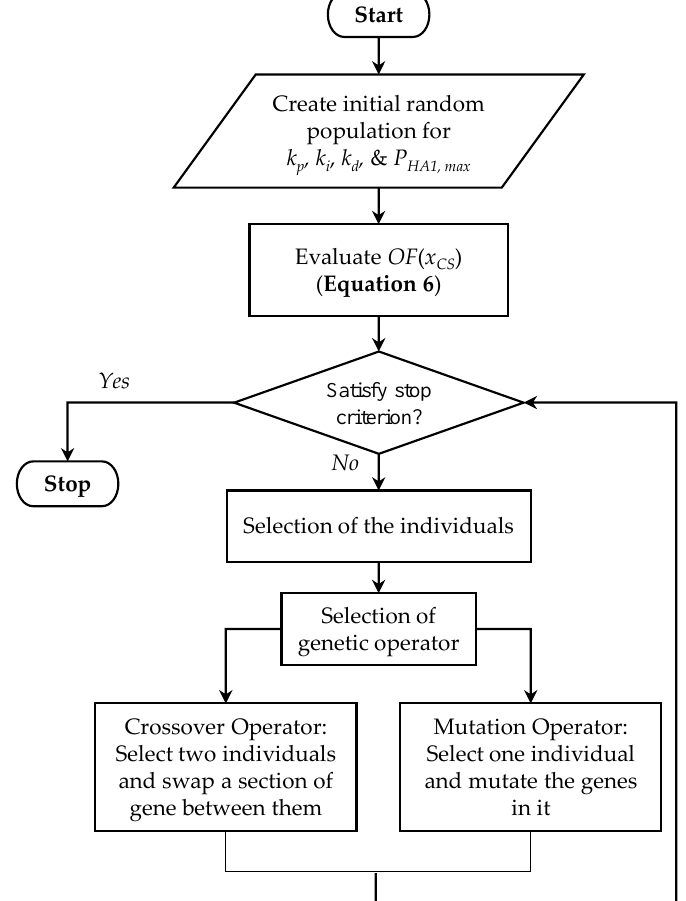
Figure 10. Procedure of parameters optimization using genetic